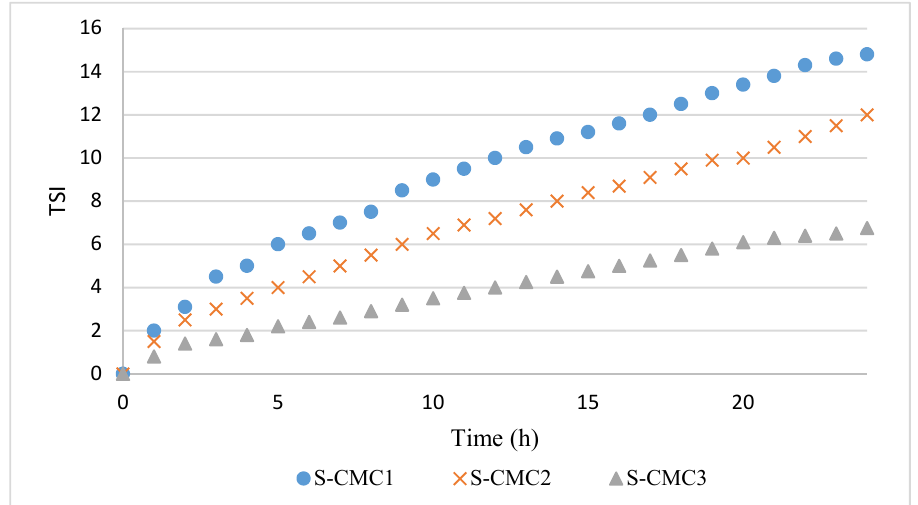
Figure 3. Profiles of Turbiscan stability index (TSI) over time for dispersions S-CMC 1 , S-CMC 2 , and S-CMC 3 .